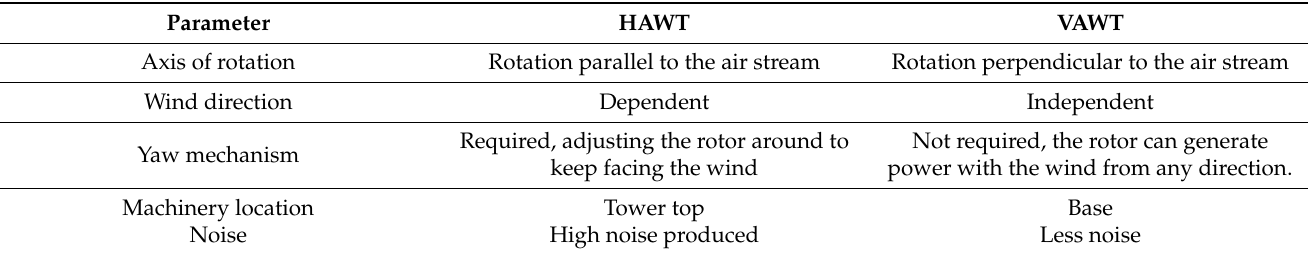
Table 2. Types of wind